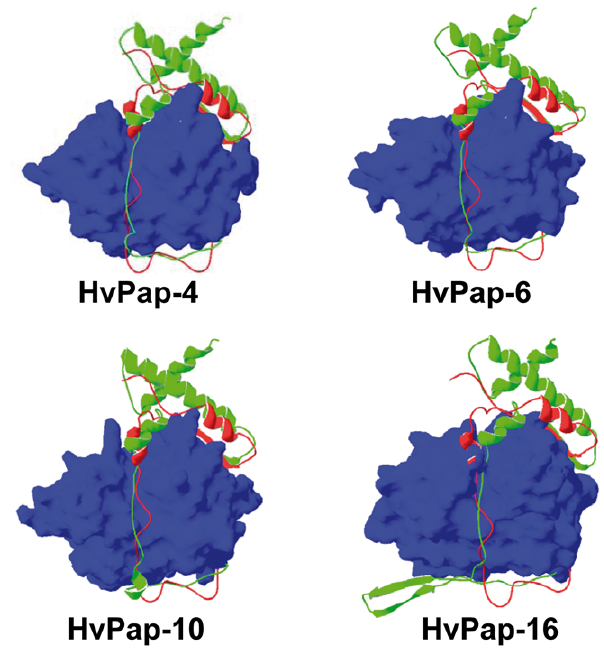
Figure 4. Homology models showing the interaction of the cathepsin B HvPap-19 propeptide with barley L-like cathep- sins. Ribbon plots show the structural overlay of the propeptide sequences from HvPap-19 (red) and the barley L-cathepsins (green). Mature peptidases of barley L-cathepsins (HvPap-4, -6, -10 and -16) are coloured in blue.